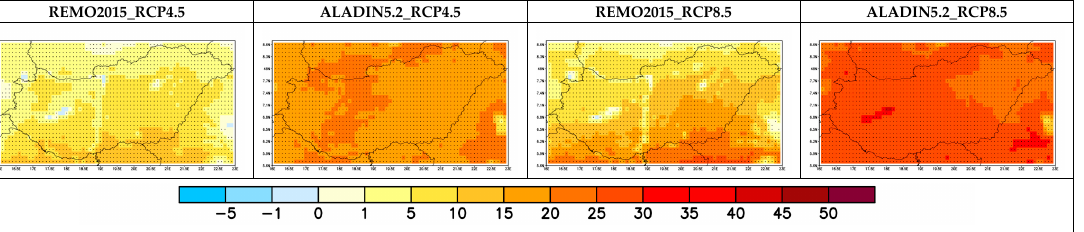
Figure 13. Change in the annual number of hot days (days) in Hungary for 2071–2100 based on the ALADIN5.2 and REMO2015 simulations. Reference period: 1971–2000.